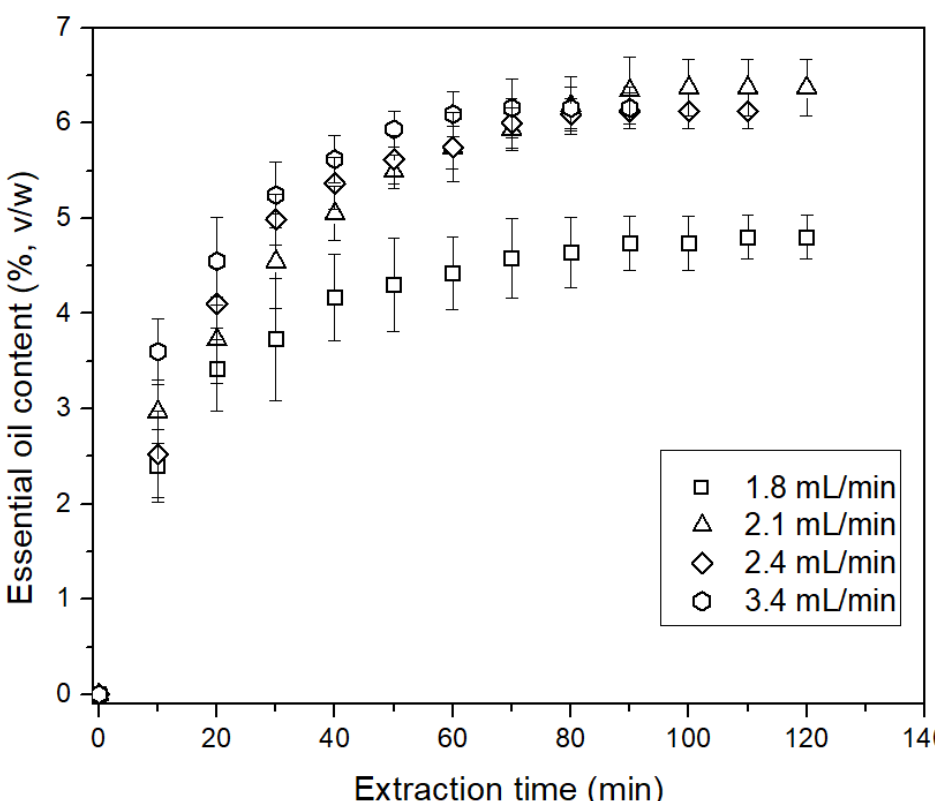
Figure 3. Effect of steam flow rate over time in steam distillation.